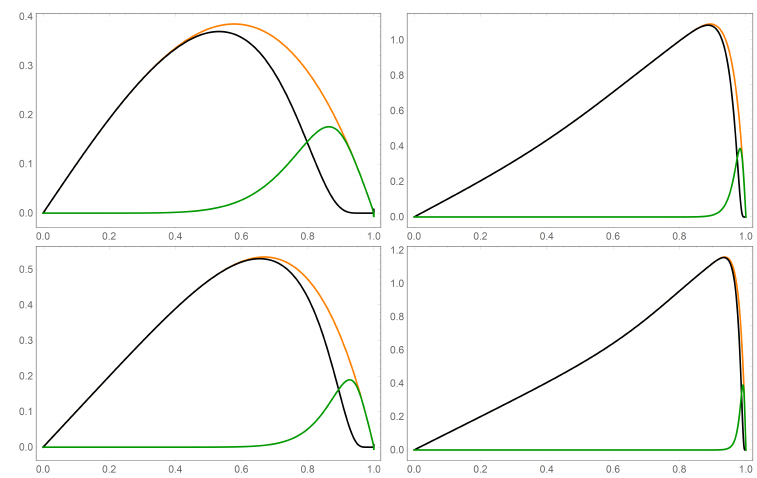
Figure 19. Illustration of the first convergence approximates to the radial function. The top row shows the case of k = 2 for p = 1 ( left ) and p = 3 ( right ) and the bottom row shows the case of k = 4 for p = 1 ( left ) and p = 3 ( right ). The approximation is exceptional up to the peak maximum in all cases. Beyond the peak maximum, the approximation improves both when k increases and when p increases. The black curve is the “exact” case, f 40 p and the orange is the first convergence approximate. The green is the